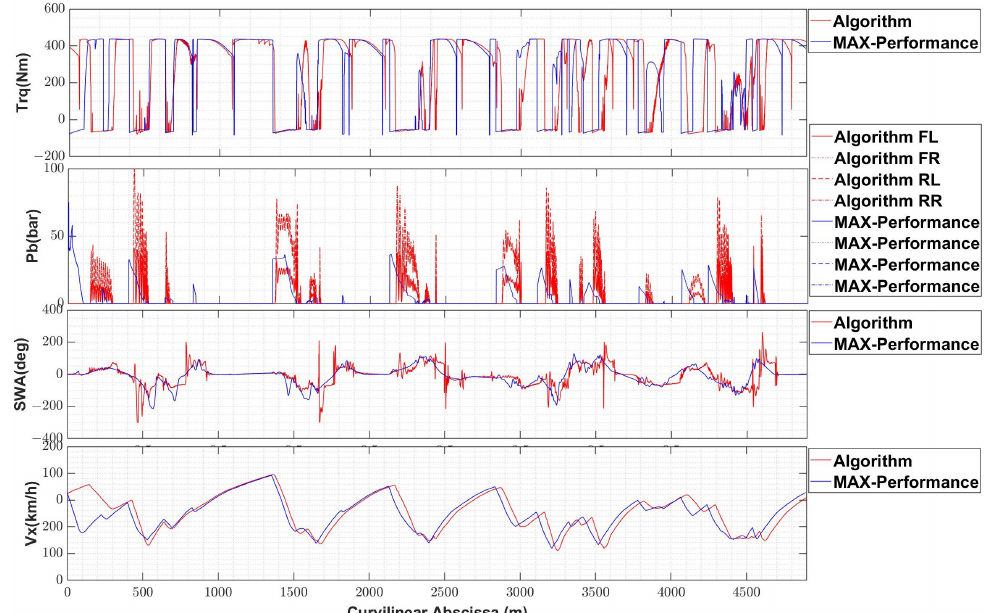
Figure 8. Comparison of the input given to the vehicle and the output longitudinal speed between the algorithm proposed and the max-performance